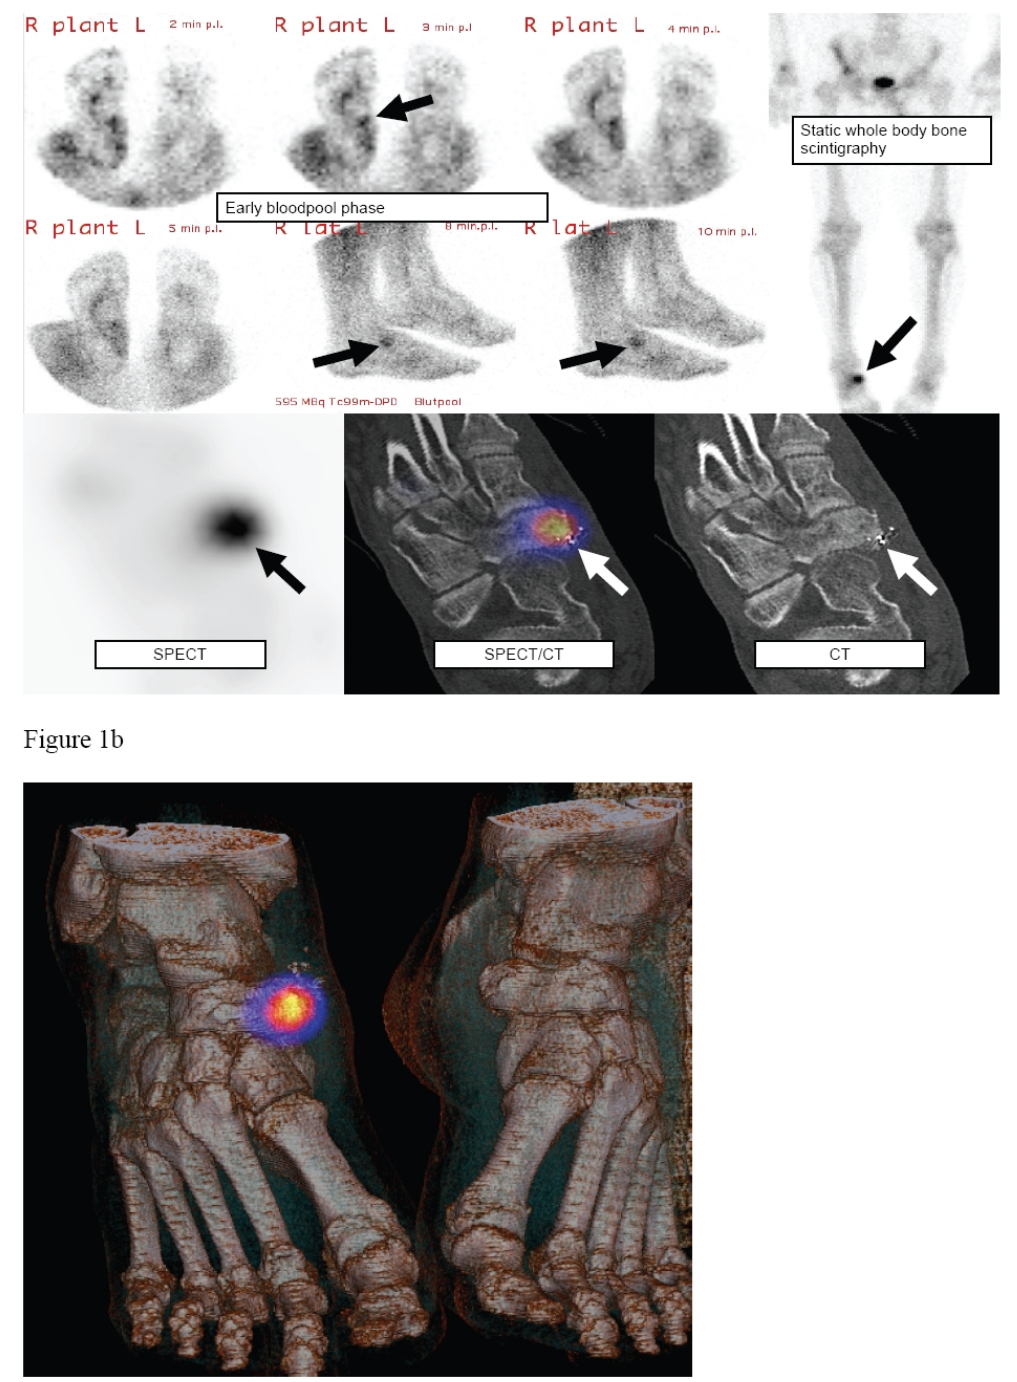
Fig. 1 Osteomyelitis of the os naviculare after gun injury 16 months ago. MRI suspected osteonecrosis of the os naviculare (arrows), not confirmed by SPECT/CT. Bone scintigra- phy and SPECT/CT show focal tracer enhancement in the navicular bone indicative of osteomyelitis. Osteonecrosis would have involved the whole bone. Metallic artifacts due to bullet particles are visualized by